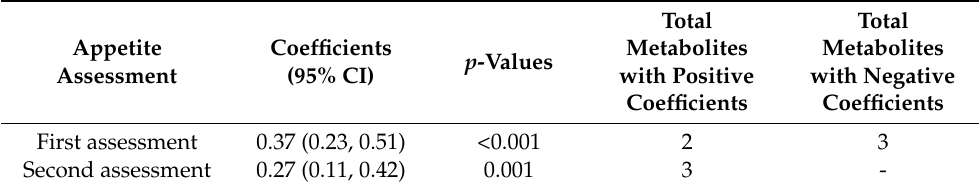
Table 3. Pearson correlation coefficients for the iAUC-VAS corresponding to the two satiety assess- ments.